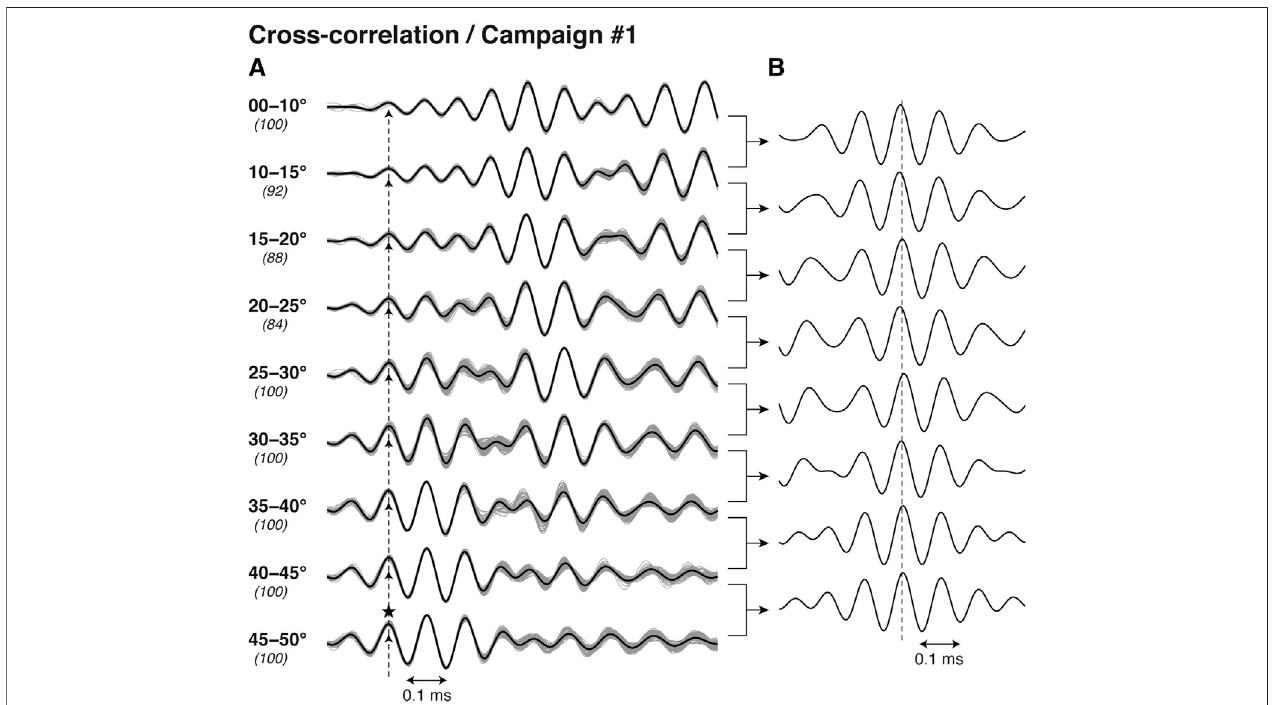
FIGURE 3 | Example of cross-correlation templates created from the data of the same campaign as shown in Figure 2 . (A) Templates (bold lines) obtained by stacking ∼ 100 cross-correlation waveforms (gray thin lines) for each zone of incident angle. Figures in bold and italics indicate incident angle ranges and the number of stacked lines, respectively. The main peak was fi rst chosen for the template at the highest incident angle zone (a star on the bottom template). Dashed upward arrows indicate the corresponding peak in the other templates determined in order from higher to lower incident angle zones. (B) Cross-correlation between the adjacent templates. A vertical dashed line indicates position of the zero